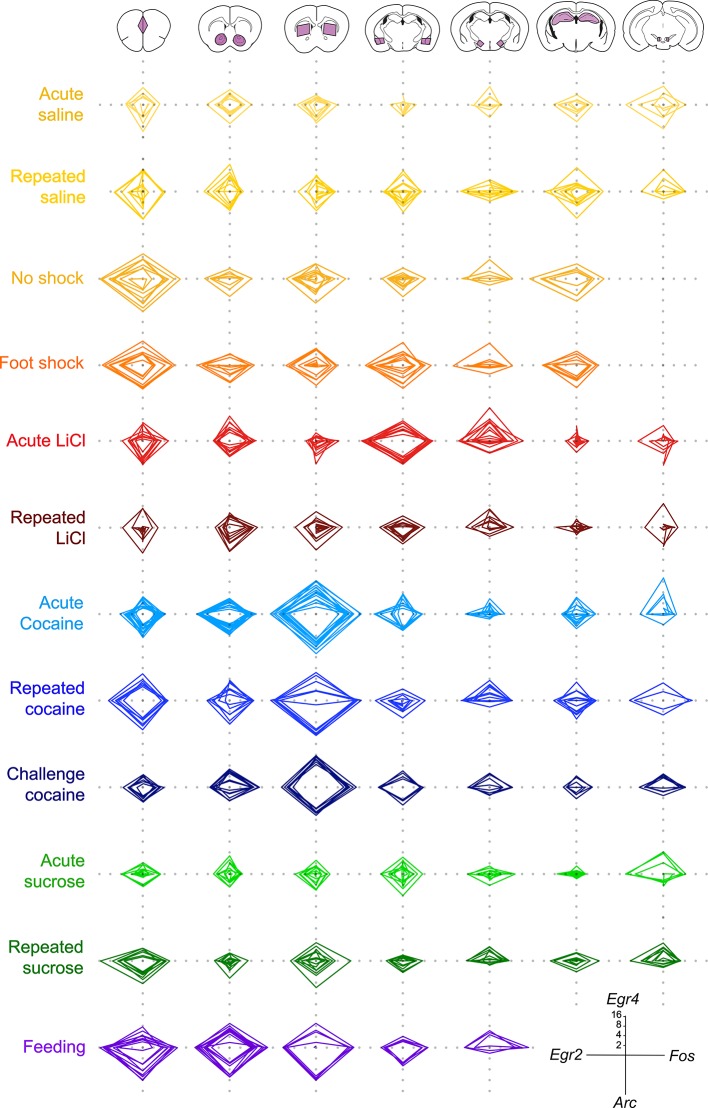
Low variability of the individual transcriptional representations of recent experience.Radar plots representing the transcriptional induction of Arc, Egr2, Egr4 and Fos, in seven brain nuclei [LCtx: limbic cortex (n = 4–14), NAc: nucleus accumbens (n = 4–14), DS: dorsal striatum (n = 4–14), Amy: amygdala (n = 4–9), LH: lateral hypothalamus (n = 3–9), Hipp: hippocampus (n = 4–8), VTA: ventral tegmental area, (n = 2–8)] 1 hr following the defined experiences. Results indicate fold induction at 1 hr in log2 scale, of individual subjects over relevant control conditions.